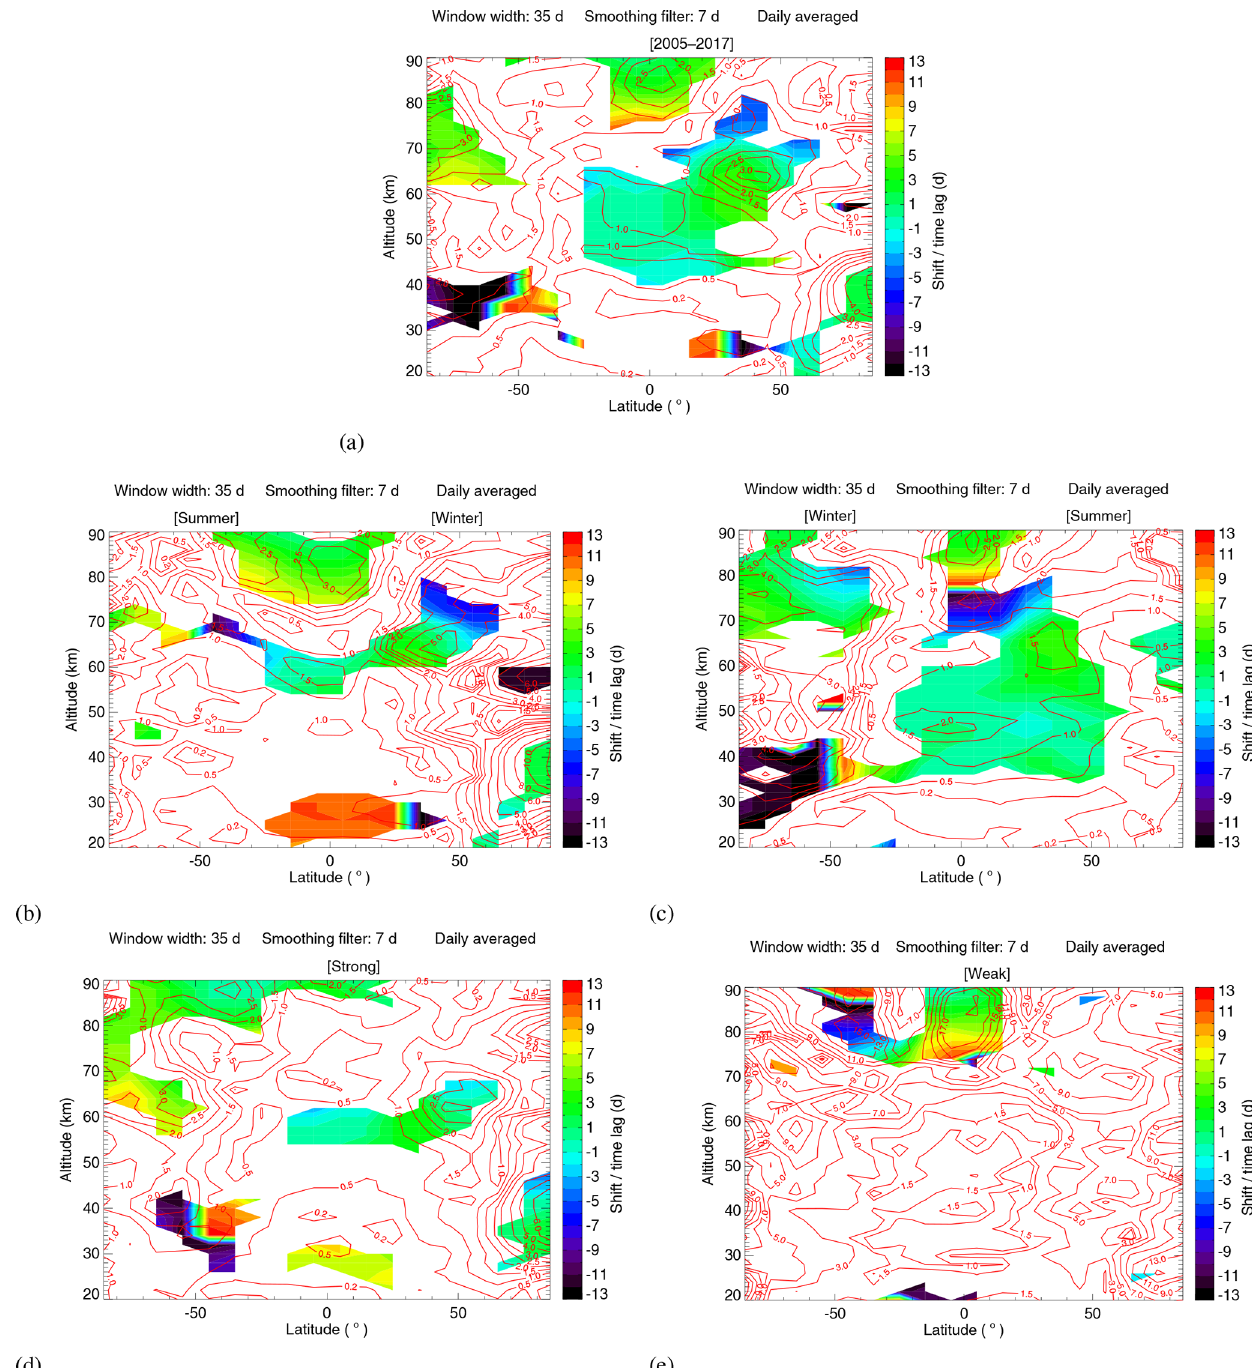
Figure 15. Sensitivity in K(100sfu) − 1 (red contour lines) and shift (color-filled contour) of the region that satisfies the condition that the significance test fraction less is than 10% for all the latitude from 85 ◦ S to 85 ◦ N and the altitude from 20 to 90km for years from 2005 to 2017 (a) , for different seasons (b–c) and for different solar activity (d–e)